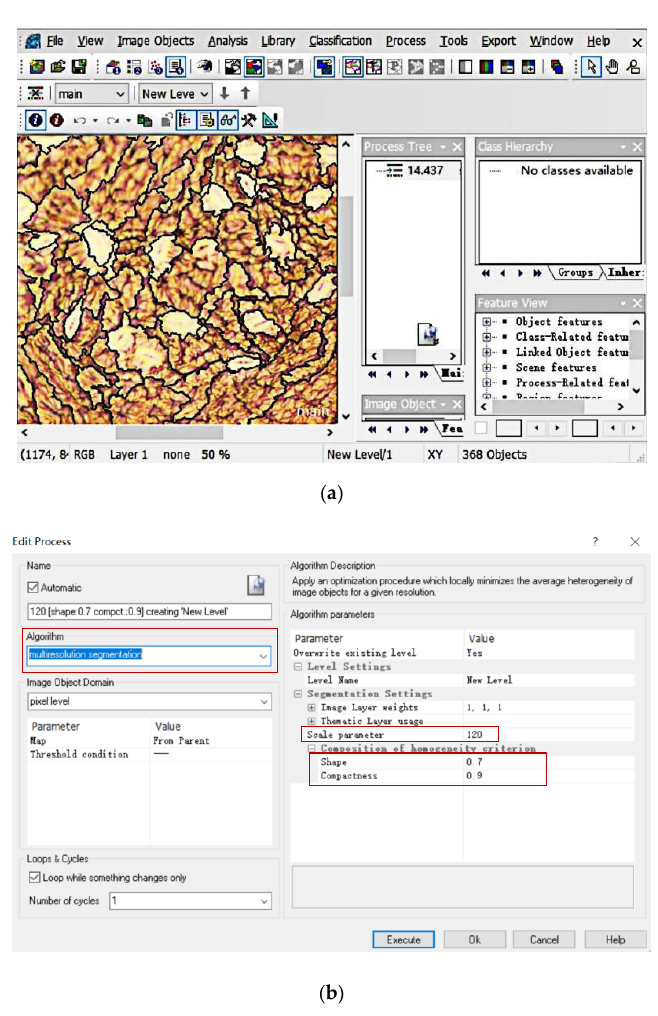
Figure 4. Object-oriented classification extraction process interface. ( a ) Total interface; ( b ) split parameter setting interface.